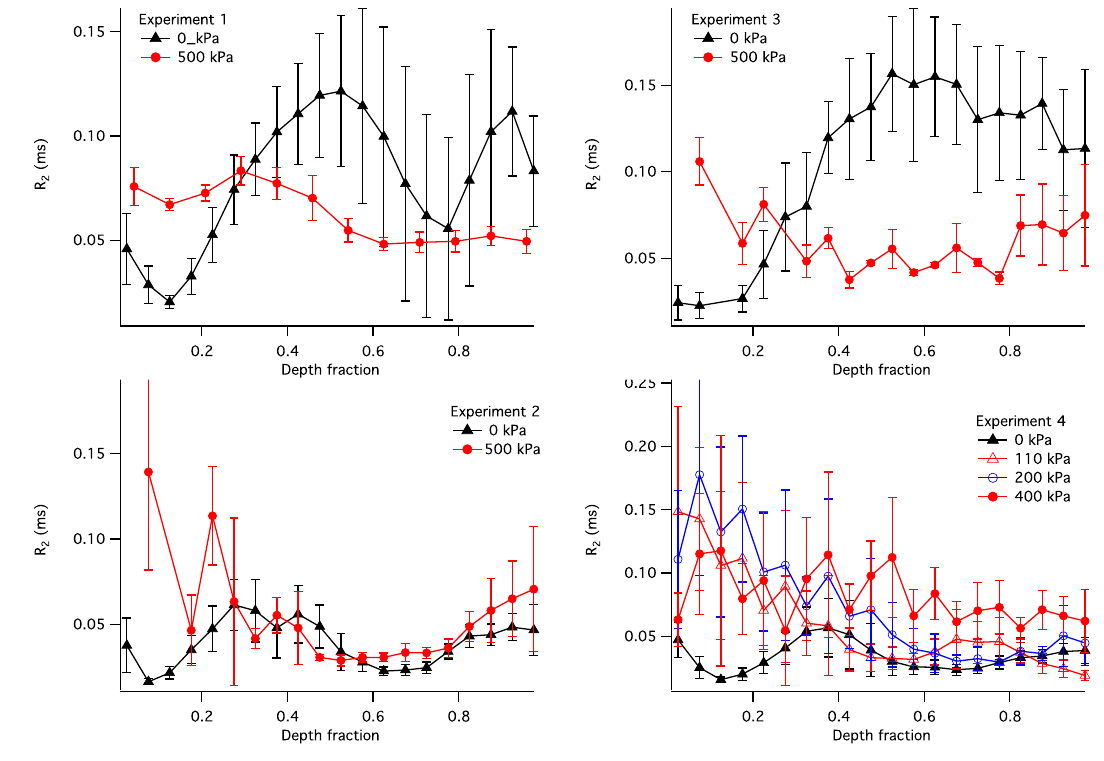
) in uncompressed (black 2 , and the error bars 2 is 2